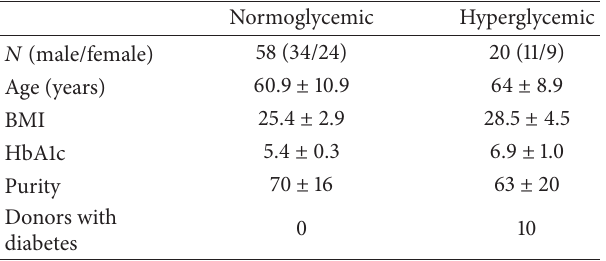
Table 1: Characteristics of human pancreatic